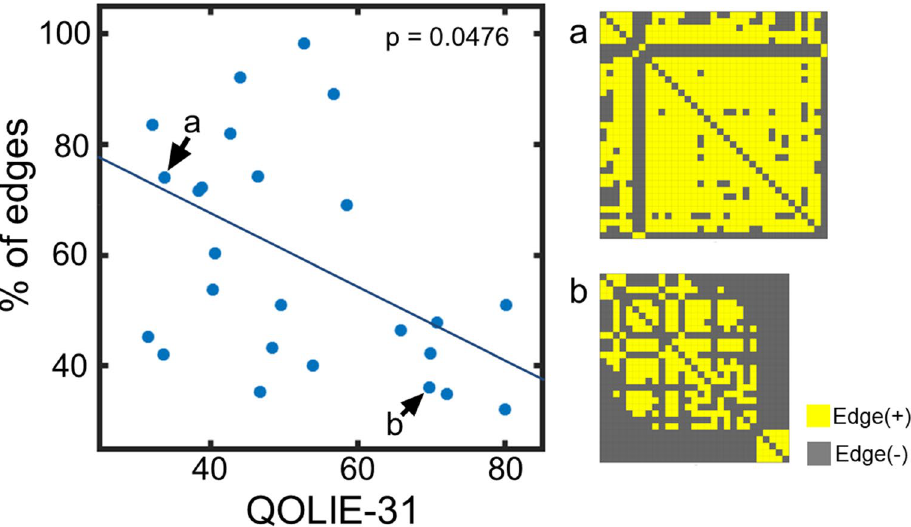
Figure 4. Functional connectivity within aR 0 was negatively related to QOLIE-31. As the percentage of edges within the abnormal regions (aR 0 ) increased, the patient’s QOL was worse (that is, QOLIE-31 was low). The right of the figure shows the visual matrices indicating the edges between abnormal regions (aR 0 ) corresponding to the plots ( a , b ) in the graph at the right side of the figure.